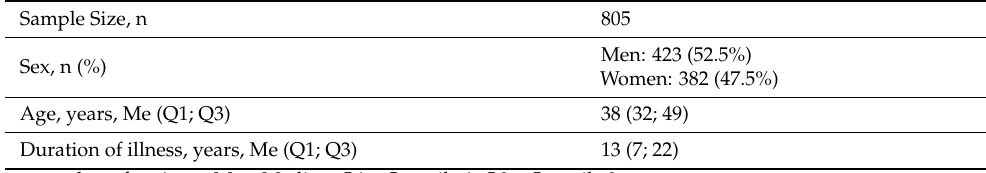
Table 1. Demographic and clinical parameters of the studied